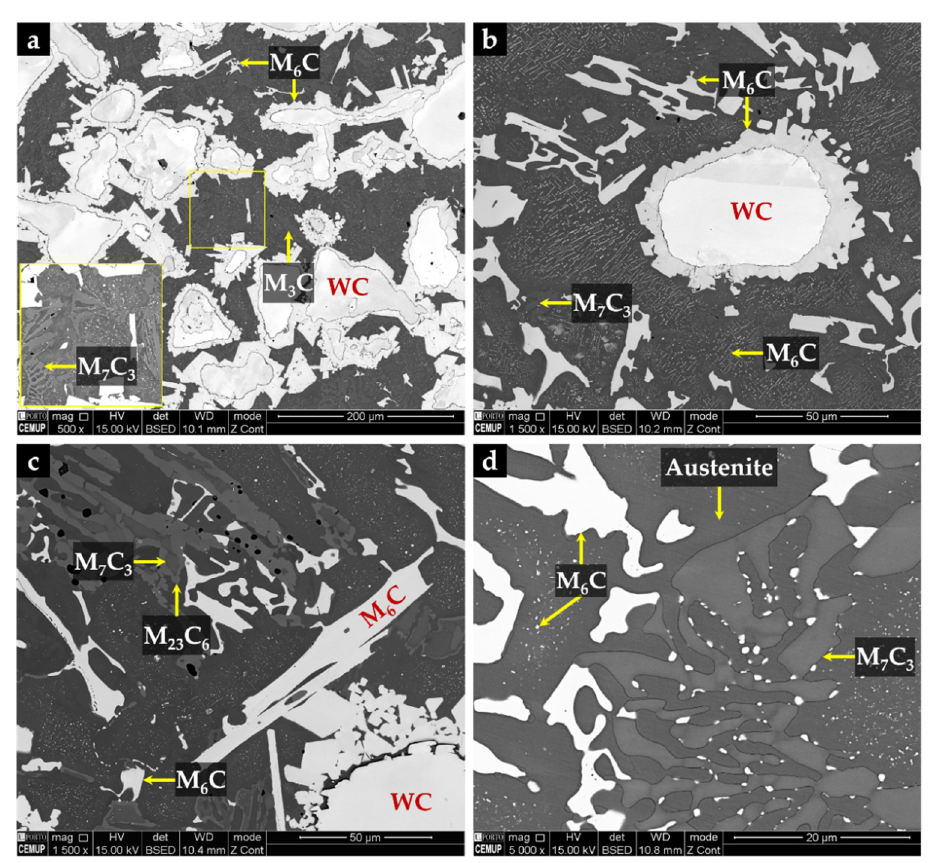
Figure 18. SEM-BSE images of the microstructure of CZ2 composite zone: ( a ) (Fe,W,Cr) 6 C precipitated around WC particles, ( b ) higher magnification of ( a ) showing fine plate-like precipitation of (Fe,W,Cr) 6 C, ( c ) carbides with a core of (Fe,Cr,W) 7 C 3 and a shell of (Fe,Cr,W) 23 C 6 , and ( d ) higher magnification of ( c ) showing the multi-phase interdendritic network.